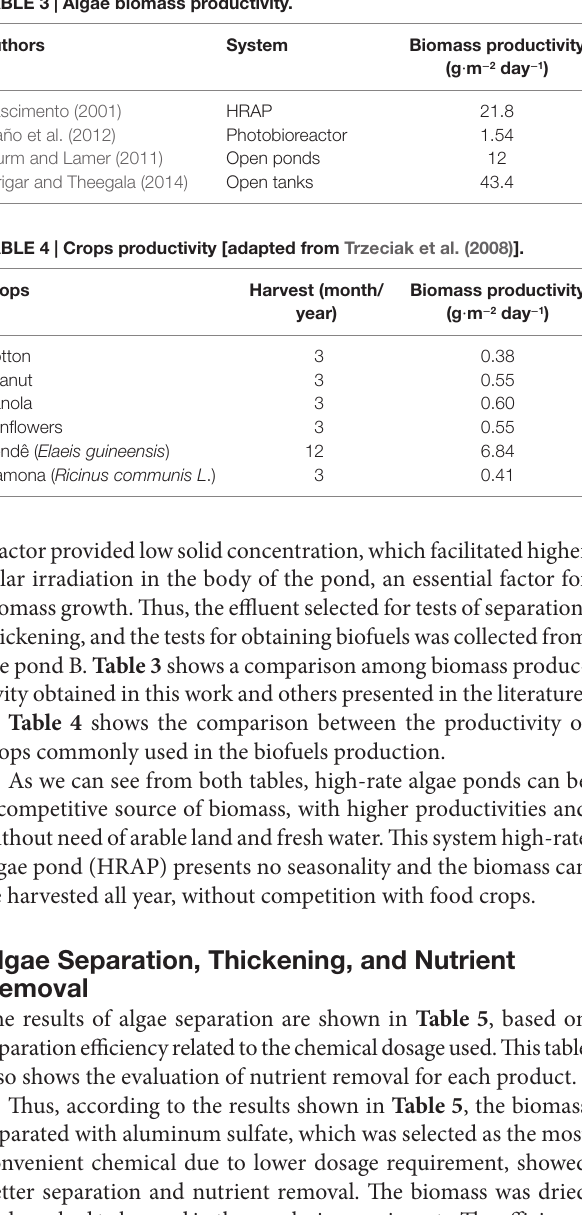
TaBle 3 | algae biomass